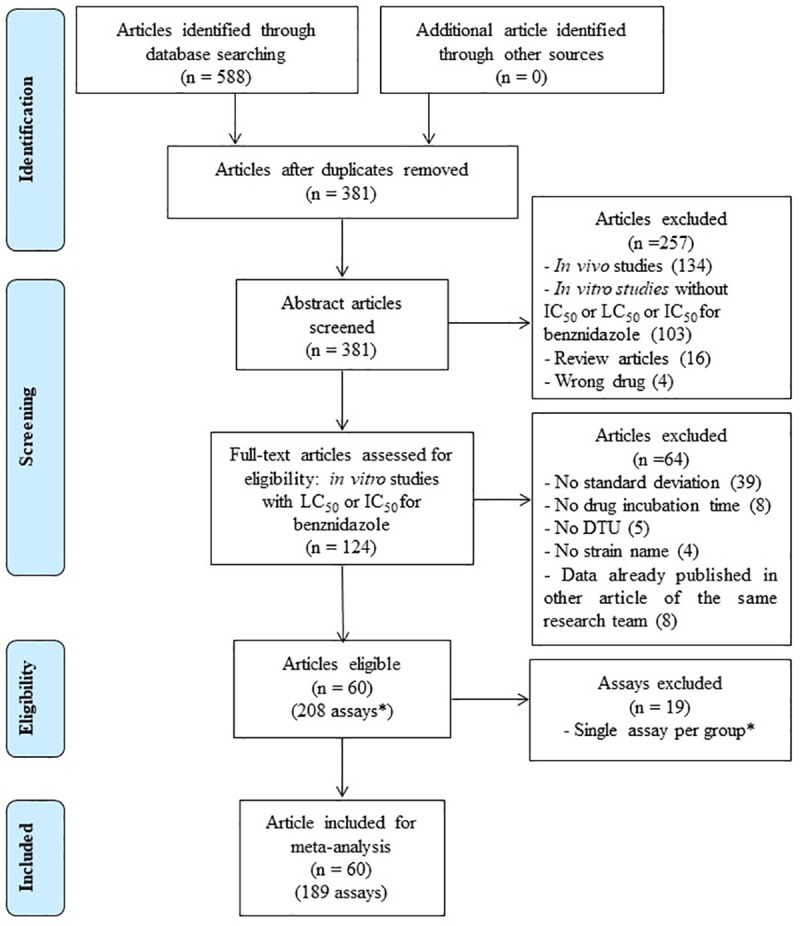
PRISMA flow diagram process for selection of eligible articles and assays.The flow diagram shows the literature search and assays selection process employed for the meta-analysis of benznidazole LC50/IC50 mean values for different T. cruzi DTUs. *If a single assay was available for a given “parasite stage/drug incubation time/DTU” combination, it was deleted from the meta-analysis.